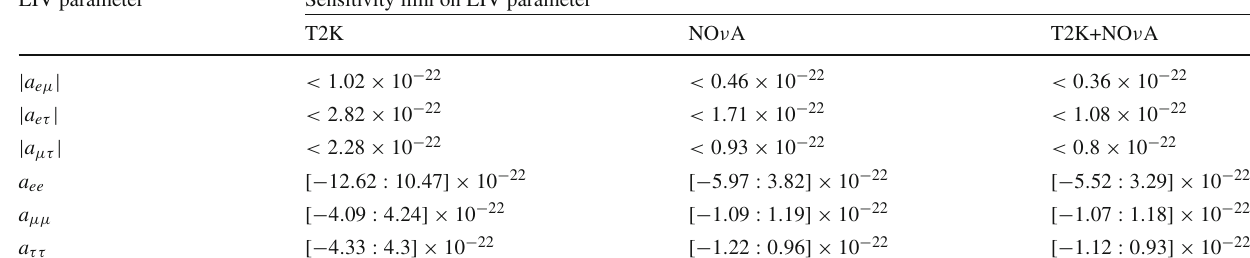
Table 2 The sensitivity limits on each LIV parameters (in GeV) at 2 σ C.L. from T2K, NO ν A, and synergy between T2K and NO ν A LIV parameter